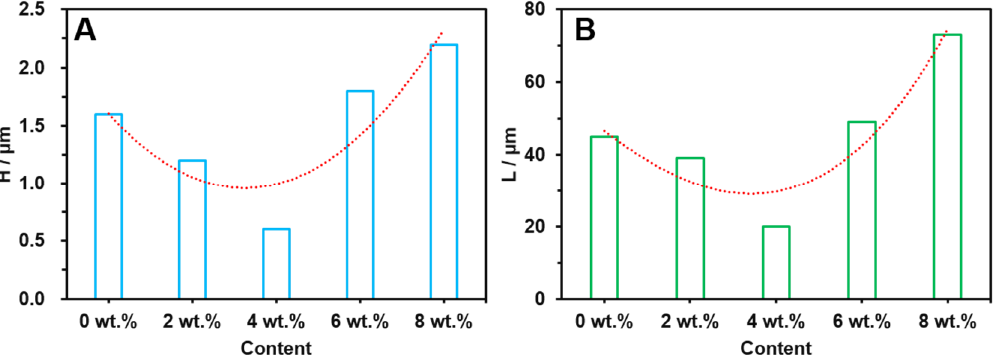
Figure 7. Ripple size: ( A ) height H and ( B ) length L of the HDPE composites with different Si 3 N 4